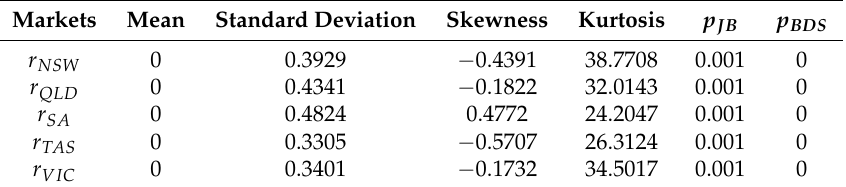
Table 1. Descriptive statistics and statistical